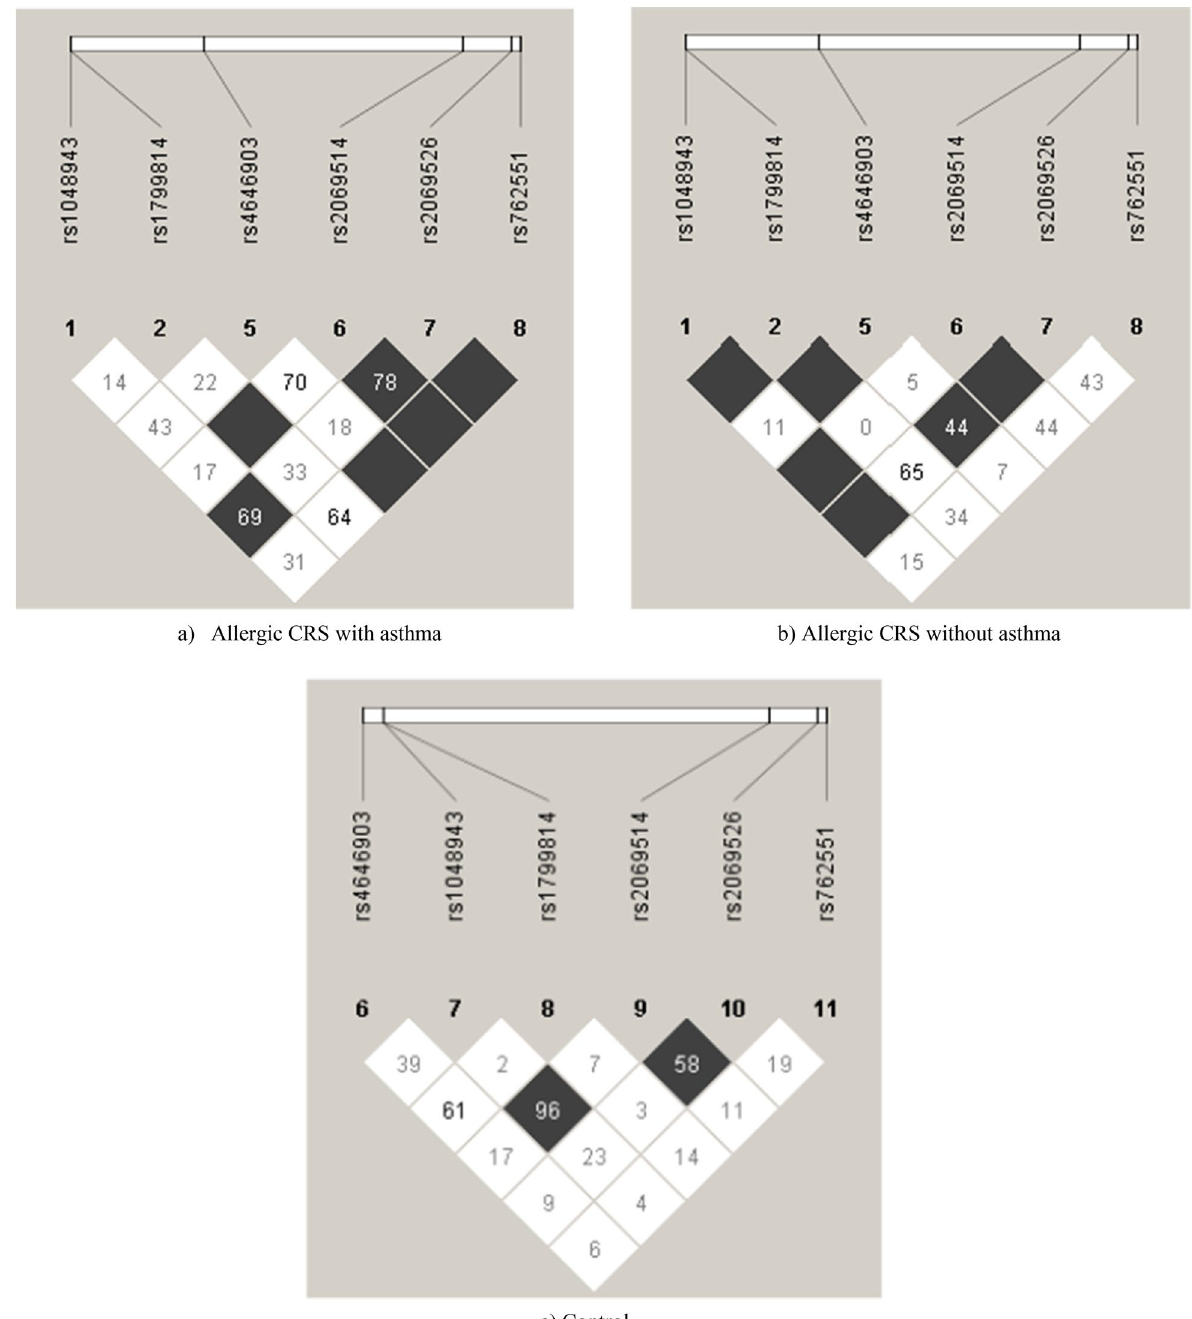
Fig. 1 Linkage disequilibrium (LD) plots of CYP1A1 and CYP1A2 genes variants in cases and controls. Pattern of Linkage Disequilibrium (LD) in CYP1A region using the Four Gamete Rule implemented in HaploView software program. Standard color scheme of Haploview was applied to display LD. The different shades of gray indicate different D values. The darker the grey shading, the larger the ׀ D’ ׀ . D’ values of 100 are taken as the strongest and the value will get